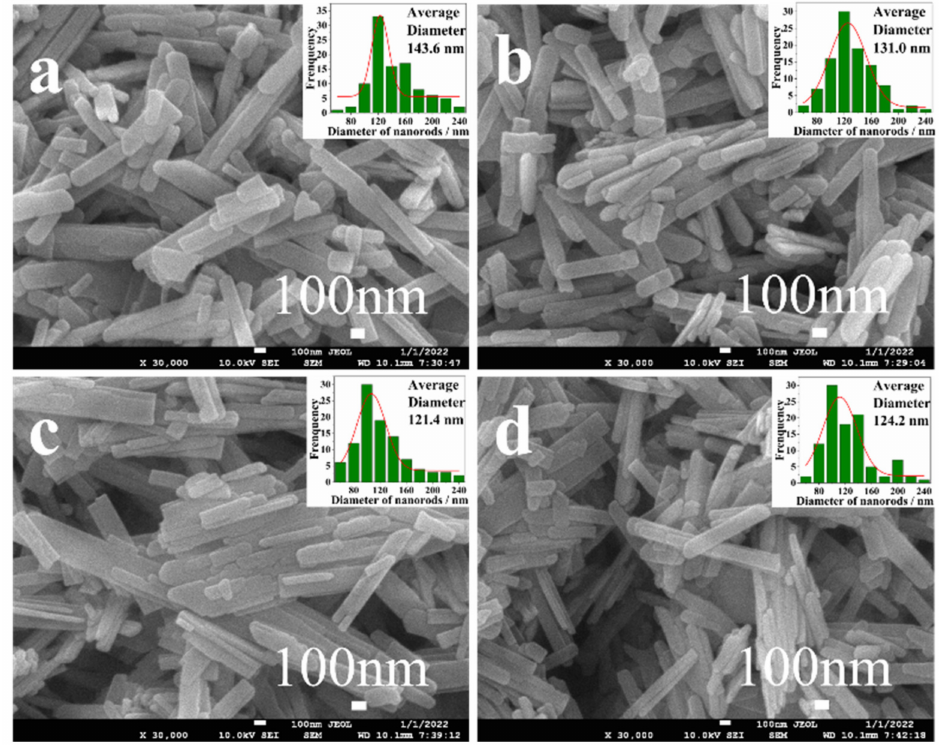
Figure 4. The SEM images of Zn-VO 2 (B) samples: ( a ) x = 0.0%; ( b ) x = 0.5%; ( c ) x = 1.5%; ( d ) x =